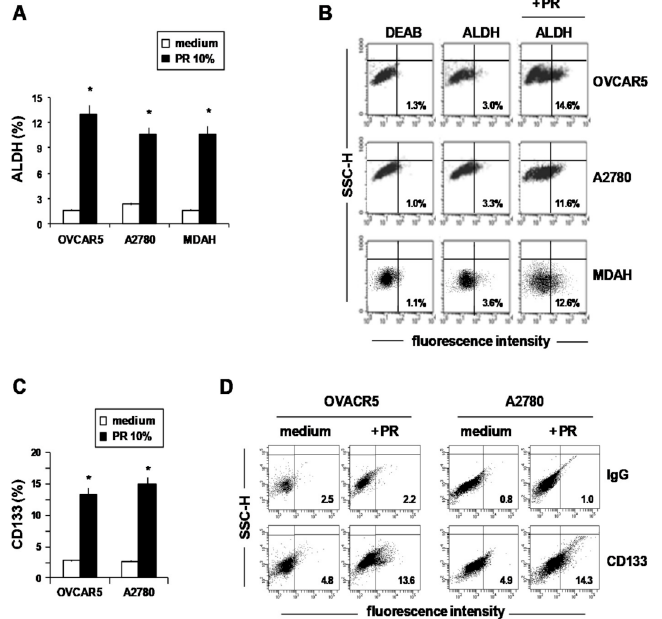
Figure 2. Human PR increased ALDH activity and CD133 expression in OvCa cells. ( A – D ) OvCa cells treated for 5 days with or without 10% PR were dissociated into single-cell suspensions by trypsinization, and then ALDH activity and CD133 expression were evaluated by means of flow cytometry. Results represent the percentage of ALDH-positive ( A ) and CD133-positive ( C ) cells. Data are expressed as mean ± SEM of three replicates with three different PR pools. * p < 0.01 (untreated vs. PR treated cells). ( B ) Representative flow cytometric dot-plots showing ALDH-positive cells. The ALDH inhibitor diethylaminobenzaldehyde (DEAB) was used as a negative control. ( D ) Representative flow cytometric histograms showing CD133